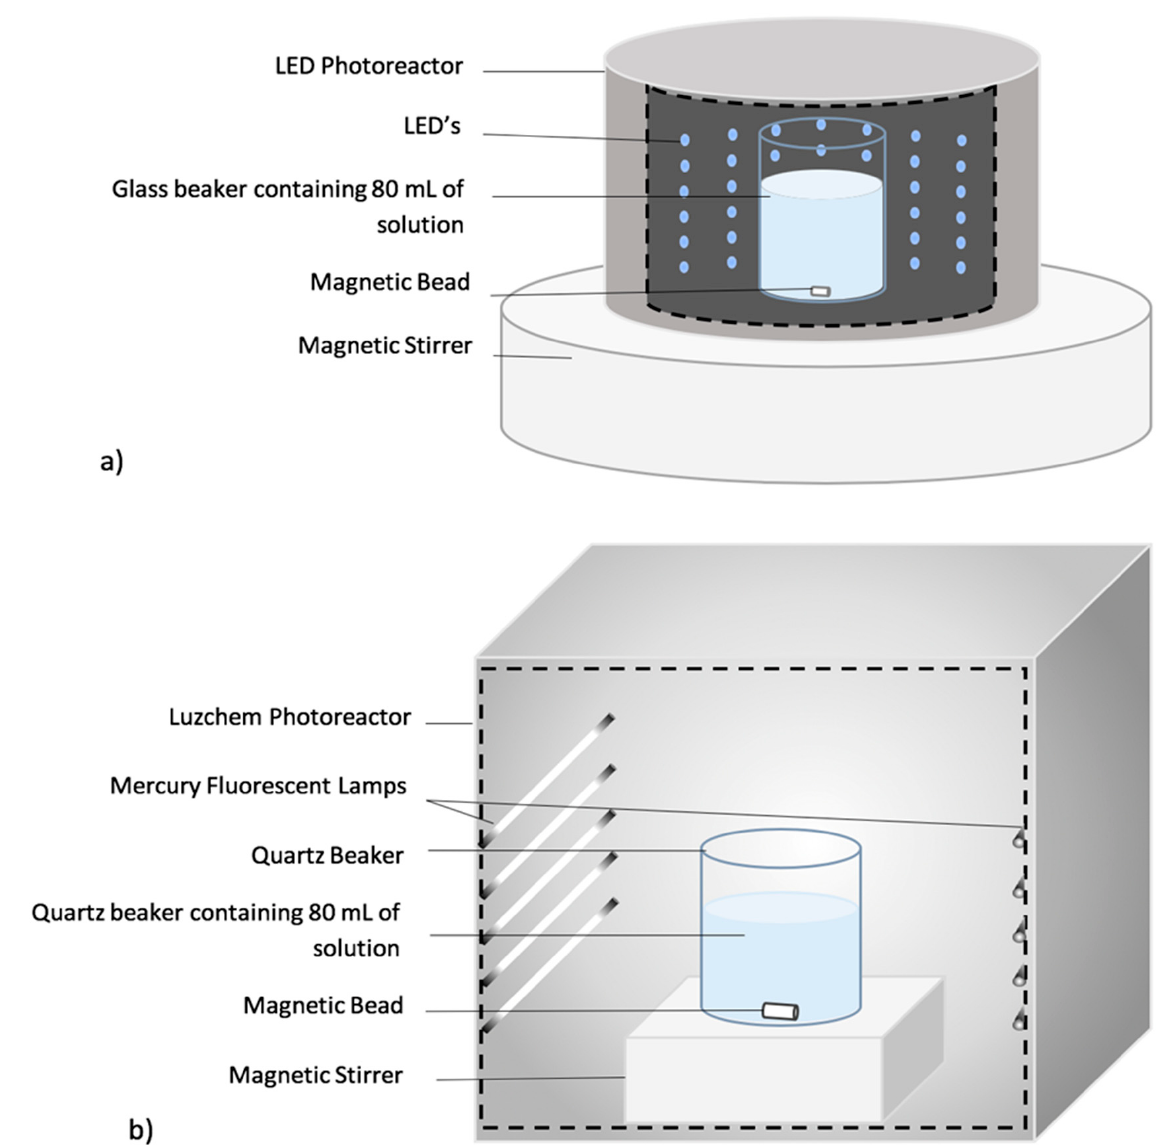
Figure 6. Schematic representation of the experimental setup, where ( a ) depicts the experiments conducted in the UVA-LED photoreactor and ( b ) depicts the experiments conducted in the Luzchem reactor. Each experiment was conducted on 80 mL of a 50 mg/L sulfolane solution with 2 g/L of the photocatalyst of interest. The schematic is not drawn to scale.